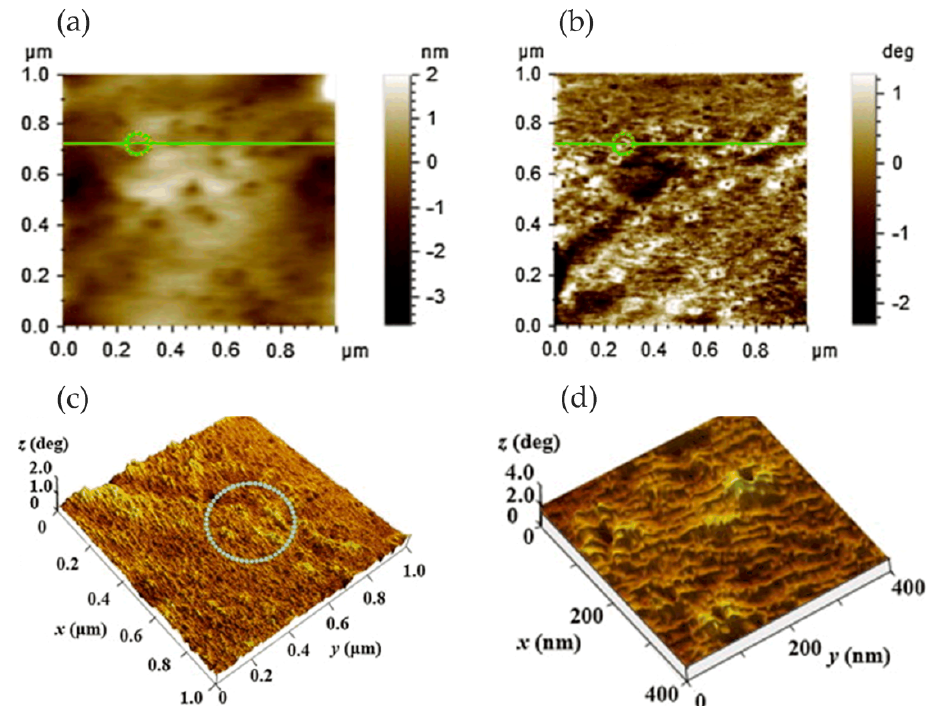
Figure 5. In situ tapping mode (TM) AFM images of the annealed Al 88 Ni 8 Ce 4 amorphous nanocrystalline sample at open-circuit potential (OCP) held for 3 min in 0.01 mol/L NaCl solution. Topography image ( a ) and phase image ( b ). Three-dimensional (3D) images of phase ( c ) and the ( d ) local enlarged phase image of the marked circle in ( c ). Reprinted with permission from Reference [40]; copyright 2014 Elsevier Ltd.